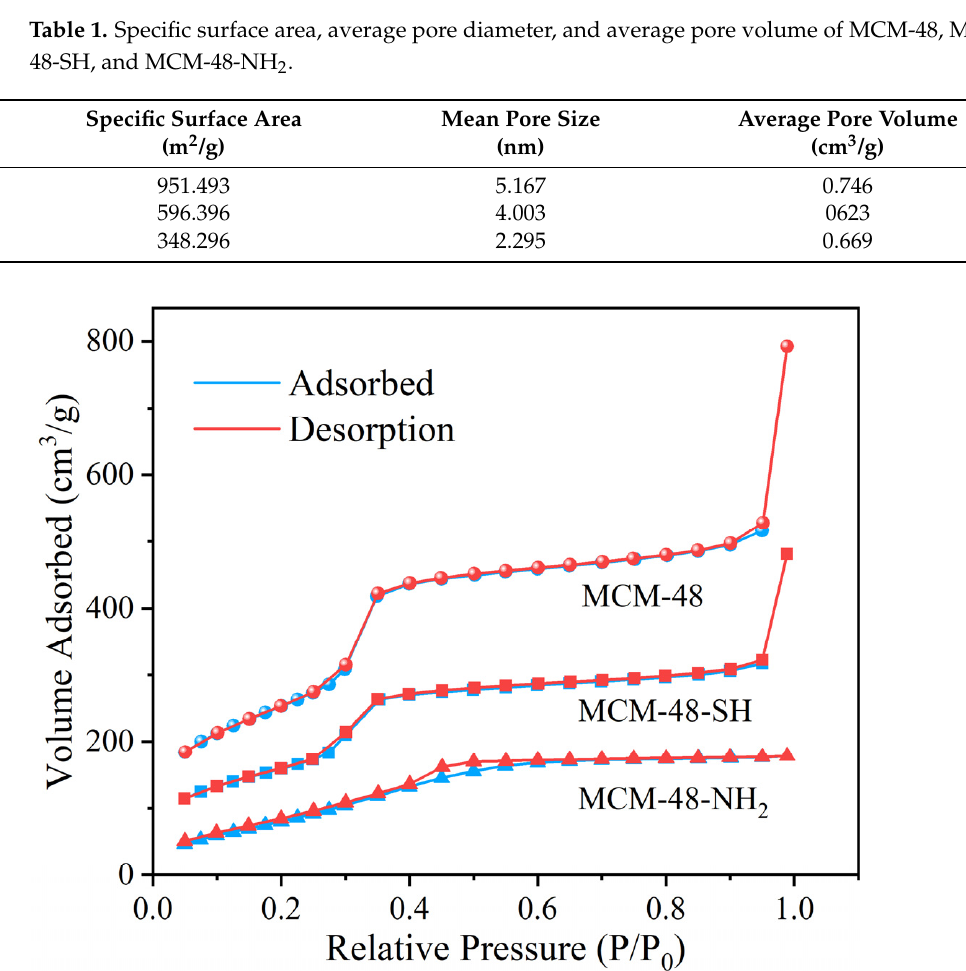
Figure 3. N 2 adsorption–desorption diagram of MCM-48-SH, MCM-48, and MCM-48-NH 2 .